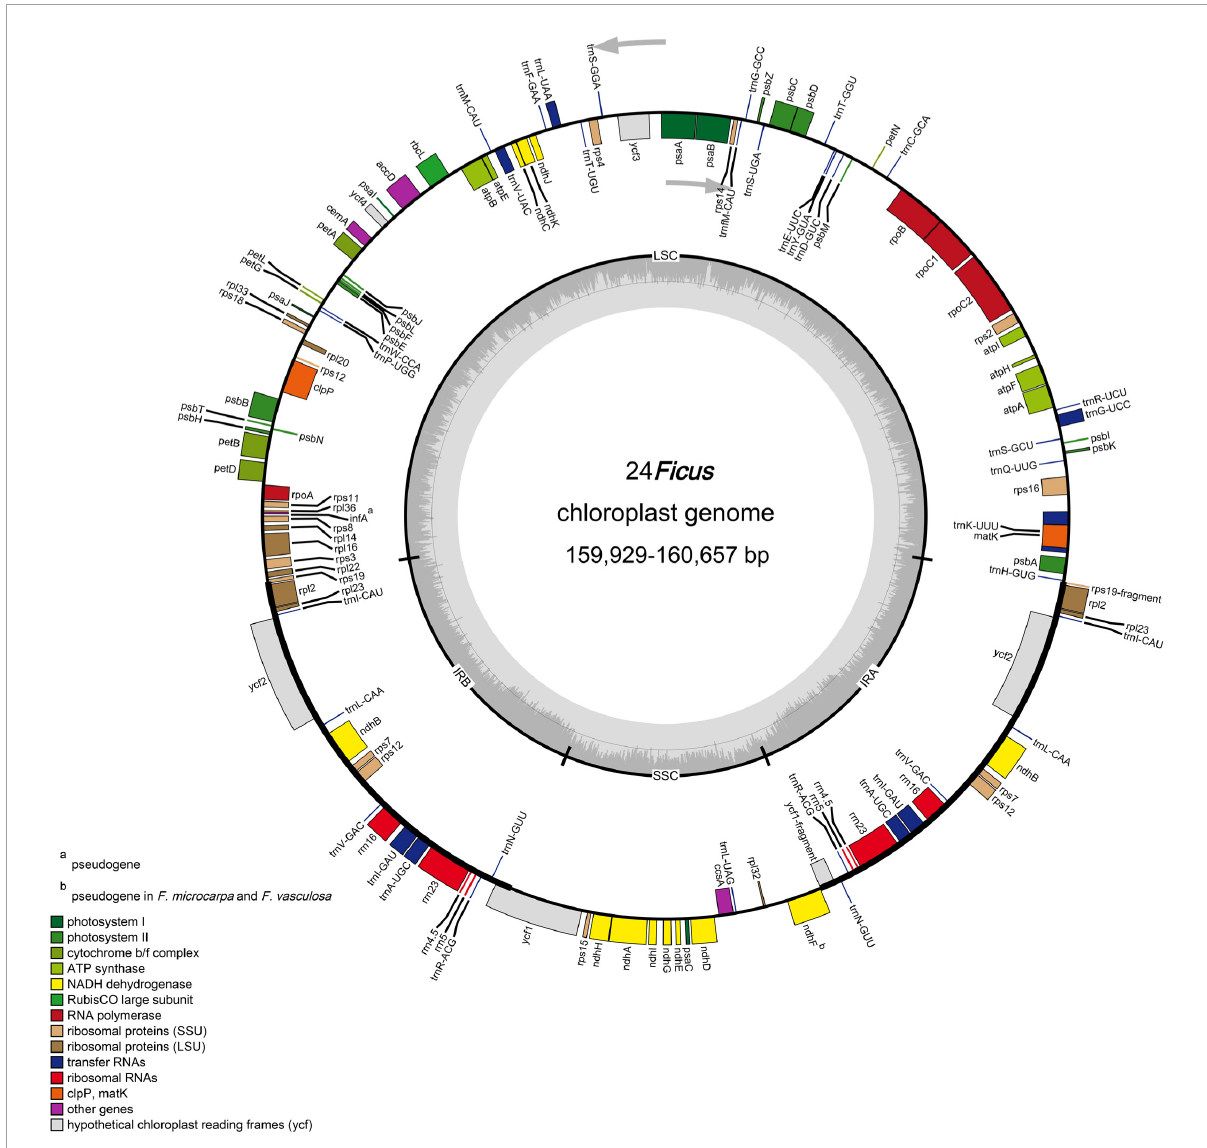
FIGURE1 Representative chloroplast genome of Ficus . Genes shown on the outside of the circle are transcribed counter-clockwise, and genes inside are transcribed clockwise. Genes belonging to different functional groups are color-coded. The darker gray in the inner corresponds to GC content, and the lighter gray corresponds to AT